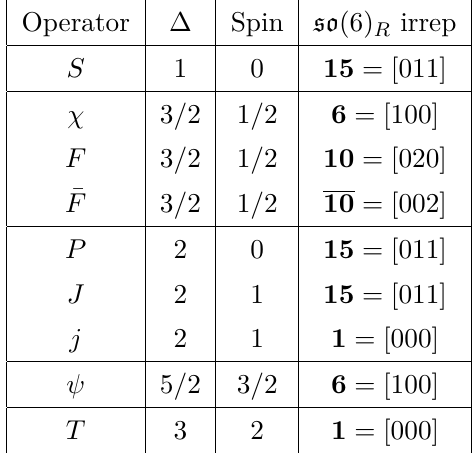
Table 1 . The conformal primary operators in the N = 6 stress tensor multiplet. For each such operator, we list the scaling dimension, spin, and so (6) R